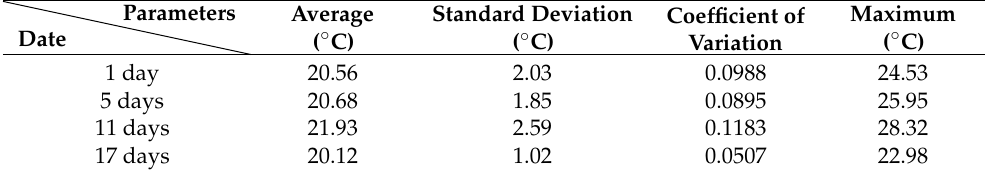
Table 7. Calculation of the statistical indexes of daily soil temperature for water storage pit